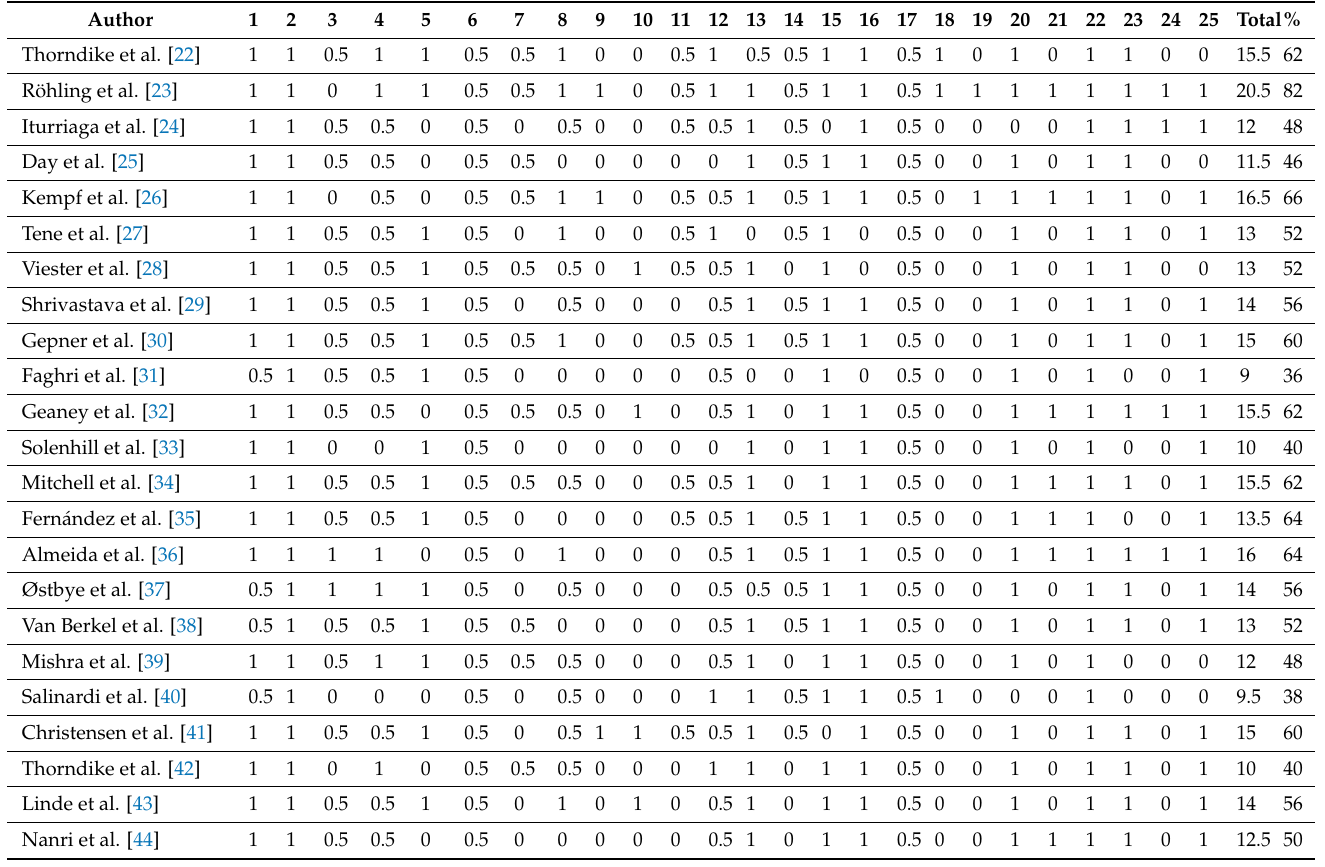
Table 2. Assessment of study quality according to the 25-item CONSORT